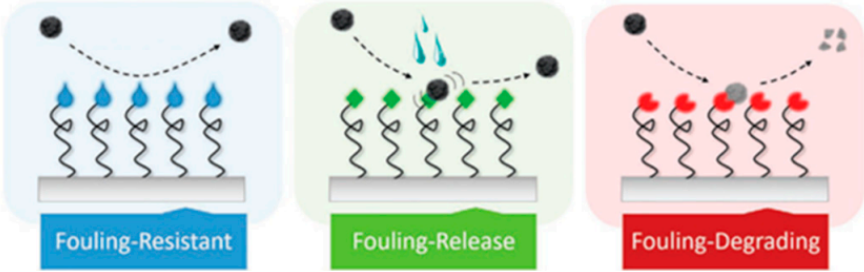
Figure 2. Illustration of the main antifouling strategies, as described by Kamperman et al. (Figure reproduced with permission from Reference